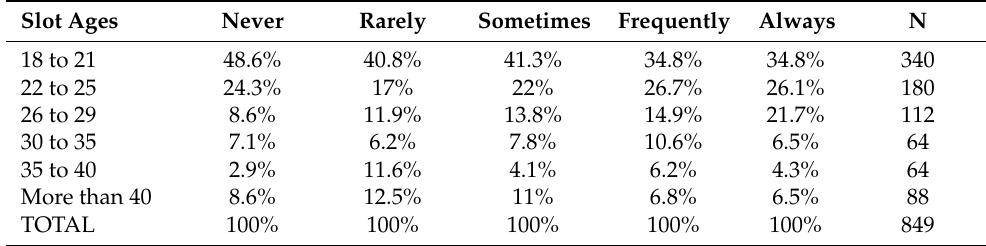
Figure 4. Percentage of participants perceiving fake news associated with media outlets. As for correlation with age, the chi square test conducted shows statistically significant differences ( p < 0.05) that can be appreciated in Tables 3 and 4, showing percentages per column and row, respectively. Undergraduate students (Slot 18 to 21) show the highest level of perceiving media outlets as distributors of fake news: Moreover, 34.8% declare that this is “Always” the case; the same percentage is revealed for “Frequently”, and 41.3% is shown for “Sometimes”. The differences are clearly marked with respect to the older participants. Table 3. Participants’ perception of media outlets as distributors of fake news (per